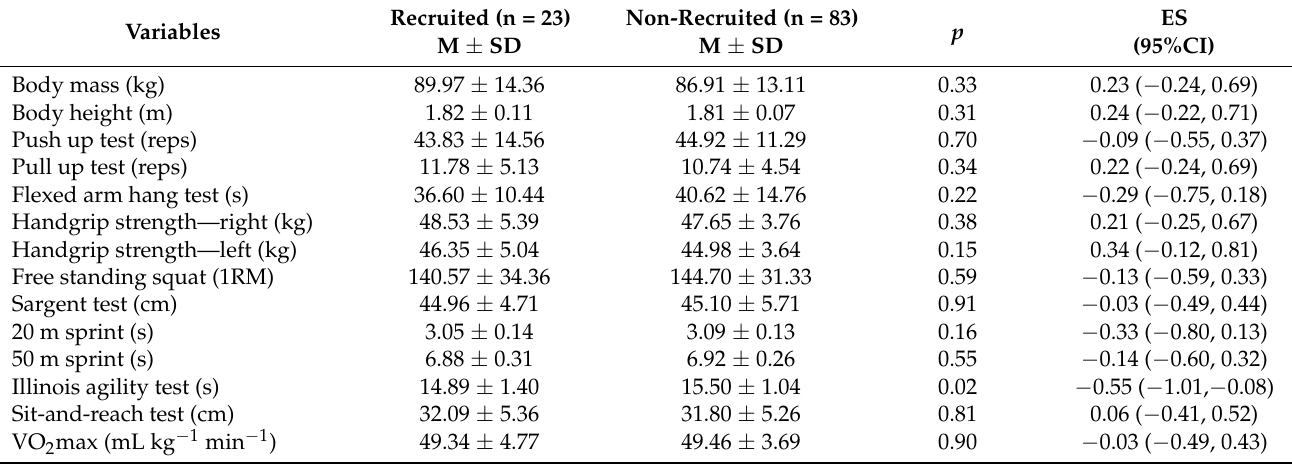
Table 2. Descriptive and comparative statistics of the anthropometry characteristics and physical fitness performance between recruited and non-recruited